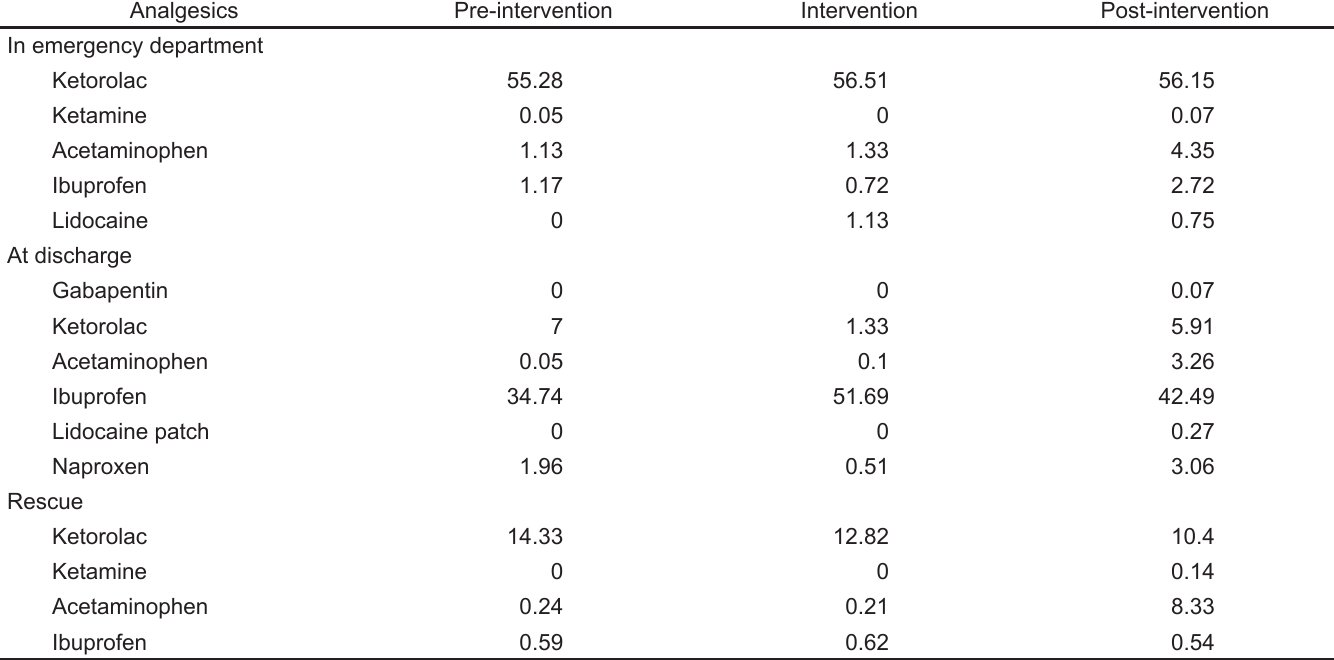
Table 3. Percentages of patients receiving individual non-opioid